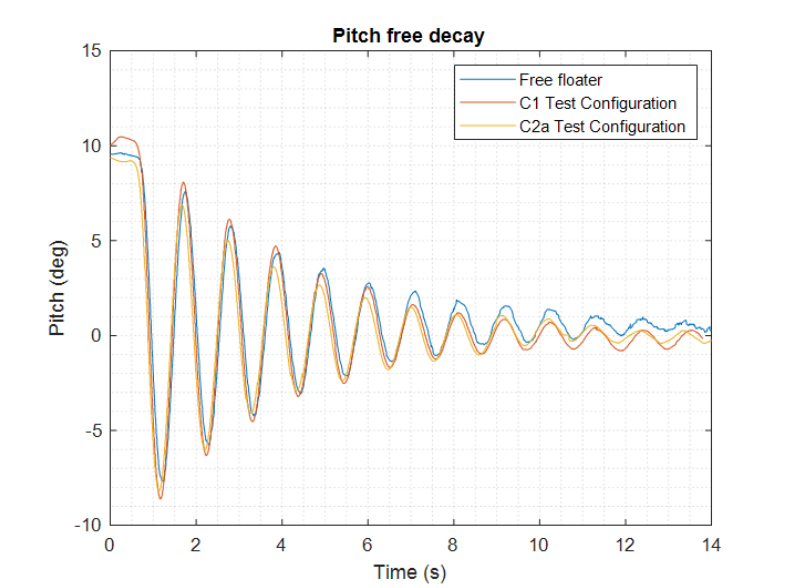
Figure 12. Pitch free decay experiments. Table 6. Regular wave tests